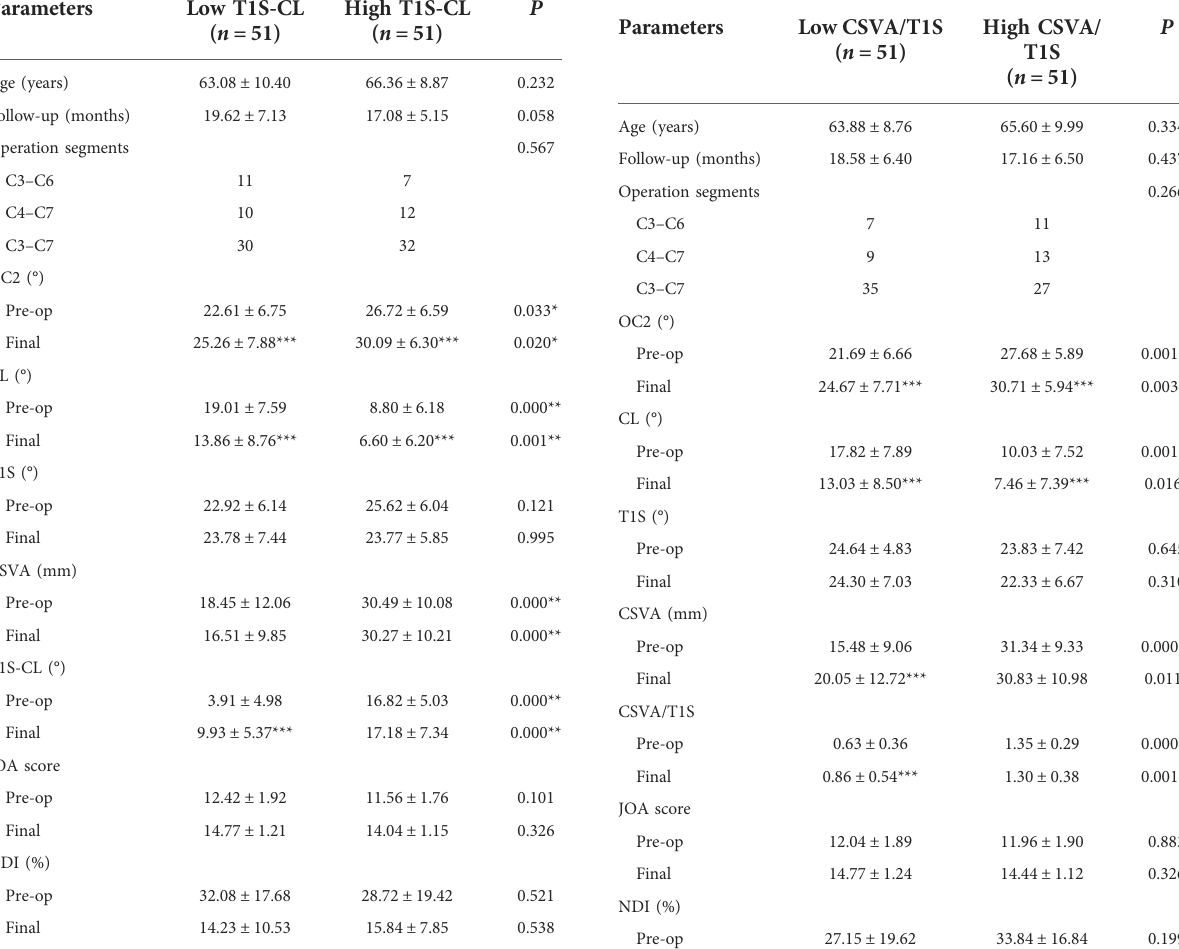
TABLE 4 Comparison of cervical sagittal parameters and HRQOL indicators between the low CSVA/T1S group and the high CSVA/T1S